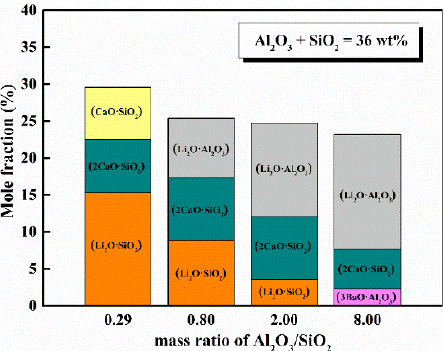
Figure 5. Mole fraction of the top three complex molecules as a function of mass ratio of Al 2 O 3 /SiO 2 .